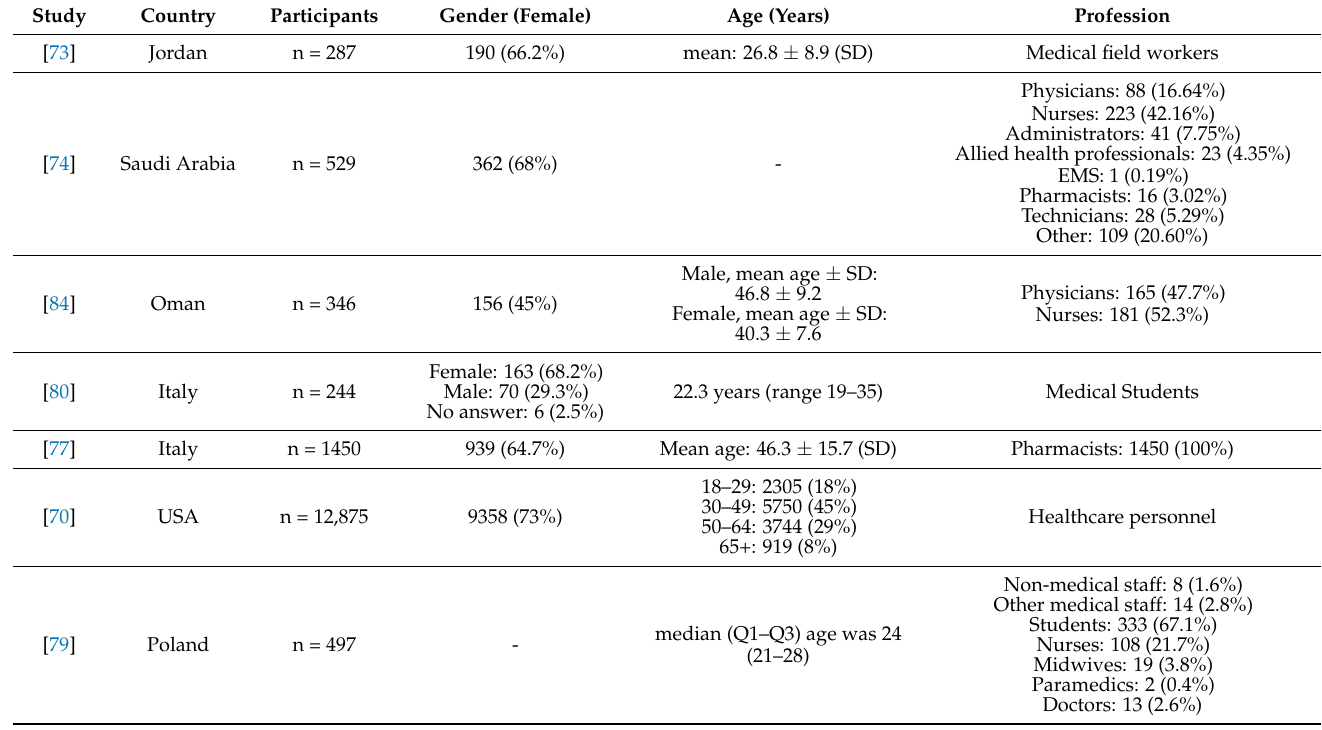
Table 5. Demographic features of the studies not included in quantitative synthesis of